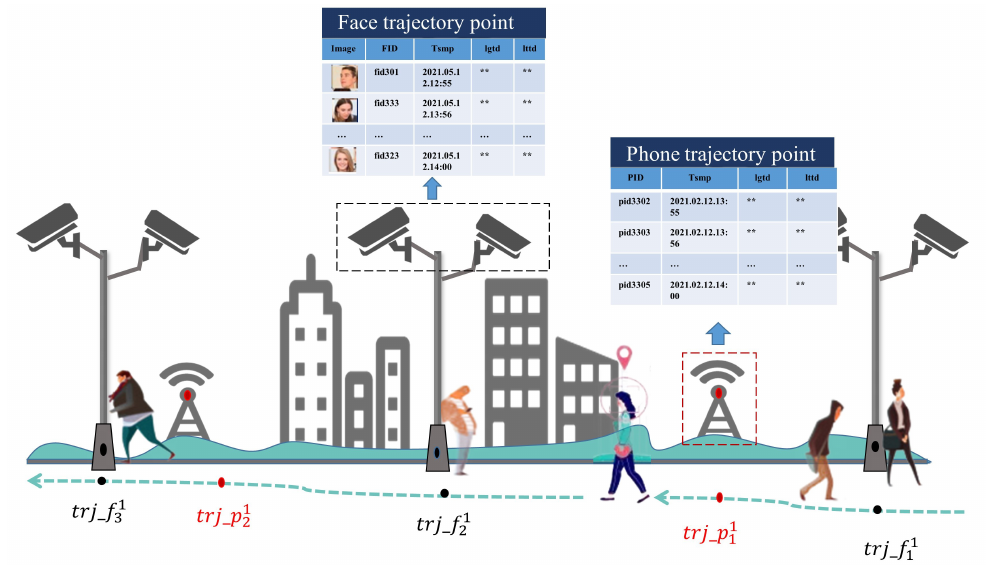
Figure 2. The face–phone trajectory matching problem (the ’**’ hides the true values for legal